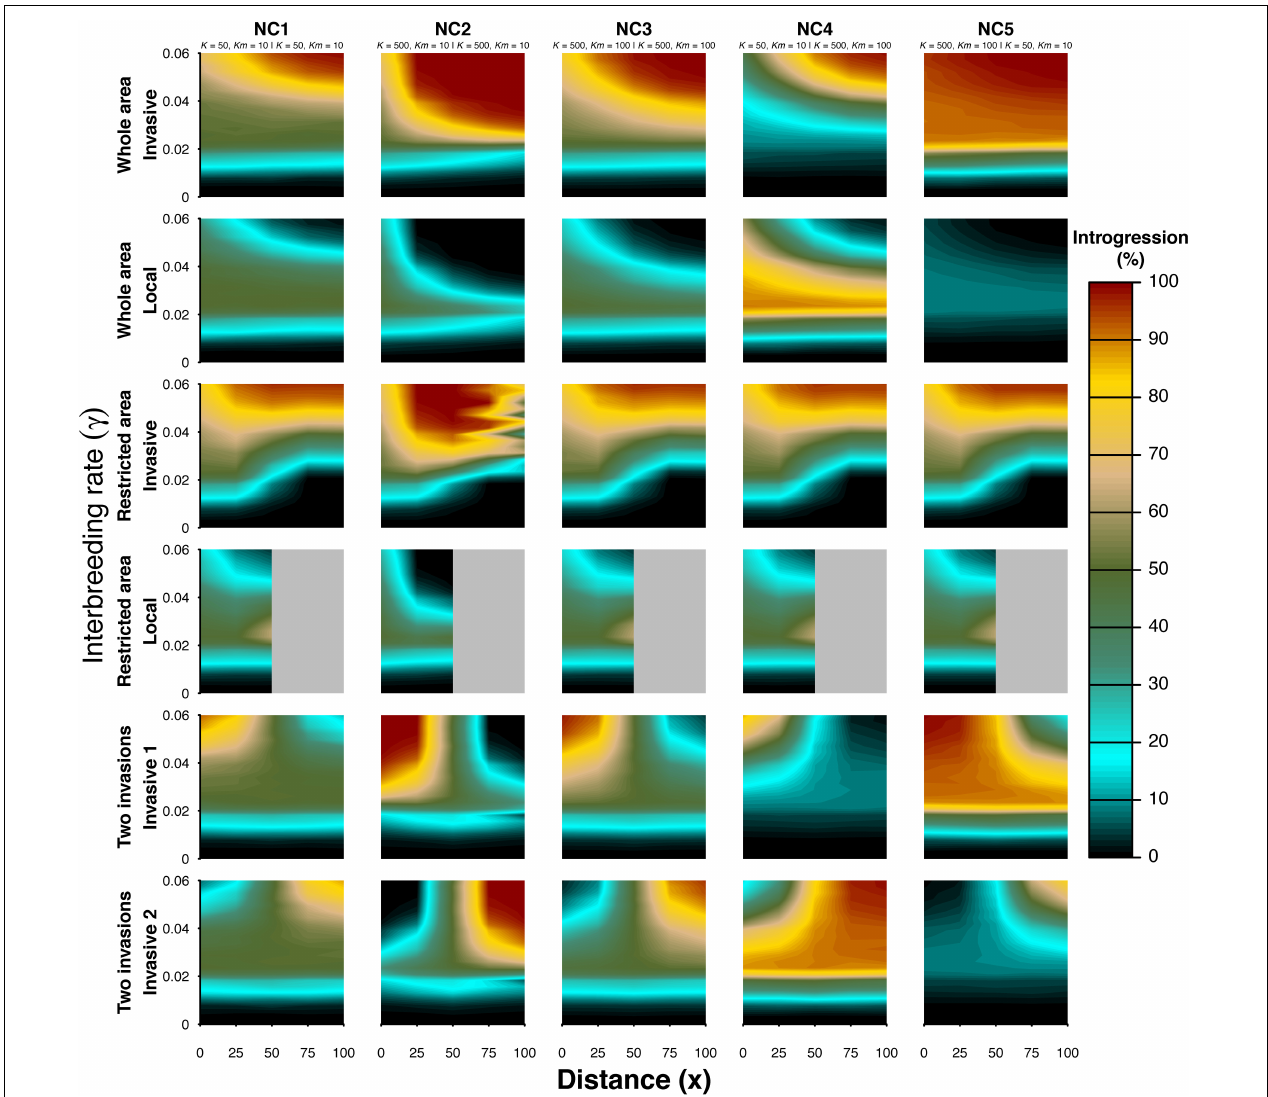
FIGURE 3 | Effect of the interbreeding rate ( γ ) and distance along the diagonal axis from the source of the invasion with a variable amount of interbreeding rate. The distance along the diagonal axis is always measured from the bottom left corner. Two taxa were simulated. The different colors denote the amount of introgression in each of the interacting taxa (%). Three scenarios of biological invasion (see Figure 1 ) and five demographic sub-scenarios (see Table 1 ) were simulated. The demographic parameters of sub-scenarios for taxon 1 and taxon 2 are also presented (taxon 1 | taxon 2). Taxon 1 is considered to be local under the “whole area” and “restricted area” scenarios but invasive under the “two invasions” scenario. Taxon 2 is always considered to be an invasive taxon. The values of introgression are averaged over 10,000